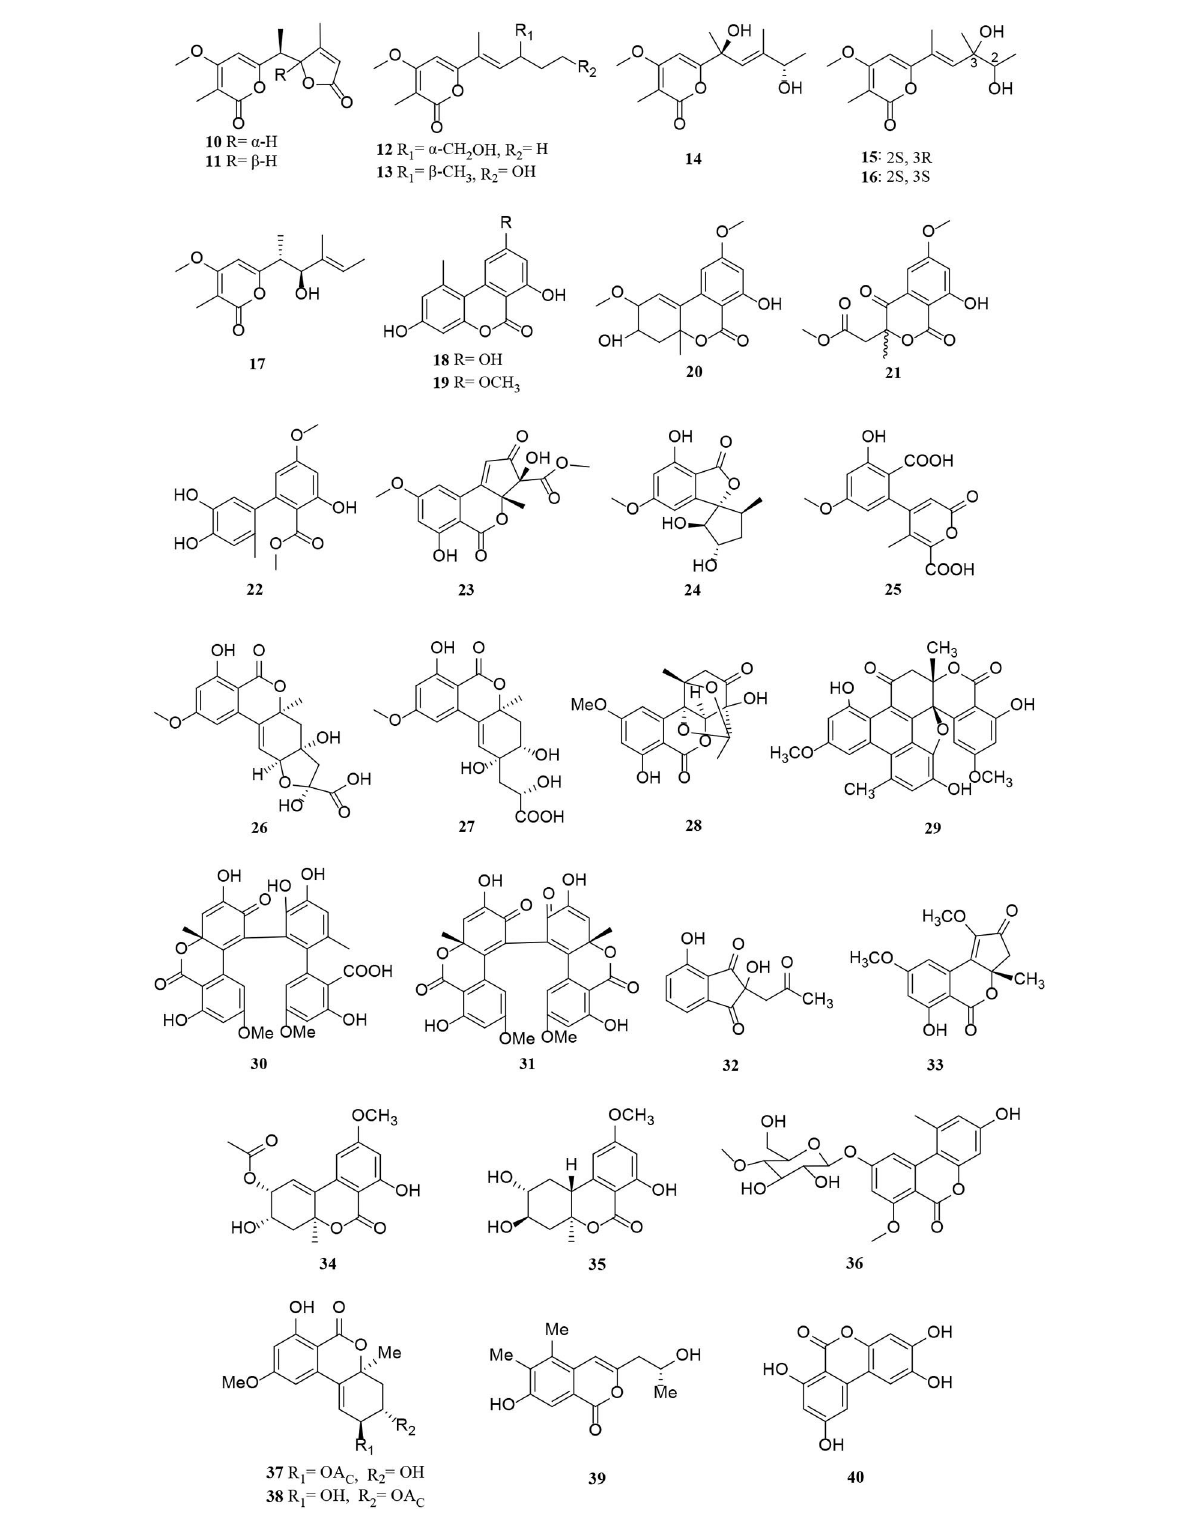
FIGURE3 Pyranone derivatives ( 10 – 40 ) from Alternaria